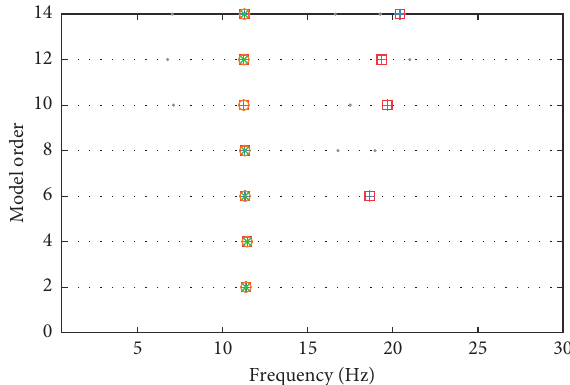
Figure 19: Stabilization diagram for NSI with reference position z ∗ � z ∗ − . Stabilization thresholds for natural frequency, damping ratio, MAC, and modal mass are 1%, 20%, 99.5%, and 20%, re- spectively. Gray dot: new (not stable) pole; blue plus: pole stable in frequency; red square: pole stable in frequency and MAC (modal assurance criterion); orange circle: pole stable in frequency, MAC, and damping; green cross: pole stable in frequency, MAC, damping, and modal mass. Table 1: Modal parameters of the two underlying linear systems identified with